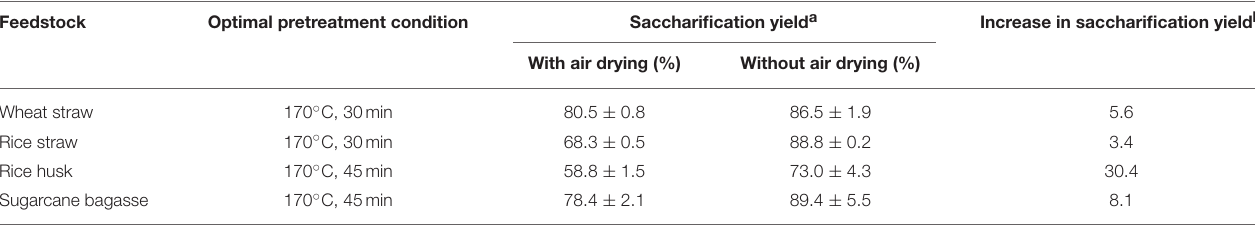
TABLE 2 | Summary of maximal glucose yields obtained after Ionosolv pretreatment of for agroresidues at 170 ◦ C using [TEA][HSO 4 ], a water content of 20 wt% and a biomass to solvent ratio of 1:10 g/g. Feedstock